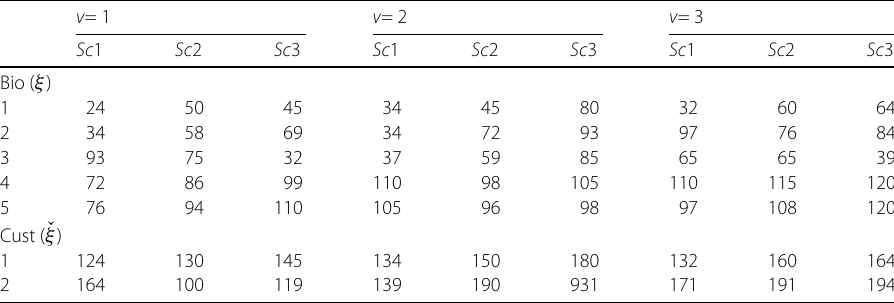
Table 4 The shipping costs ξ jltv and